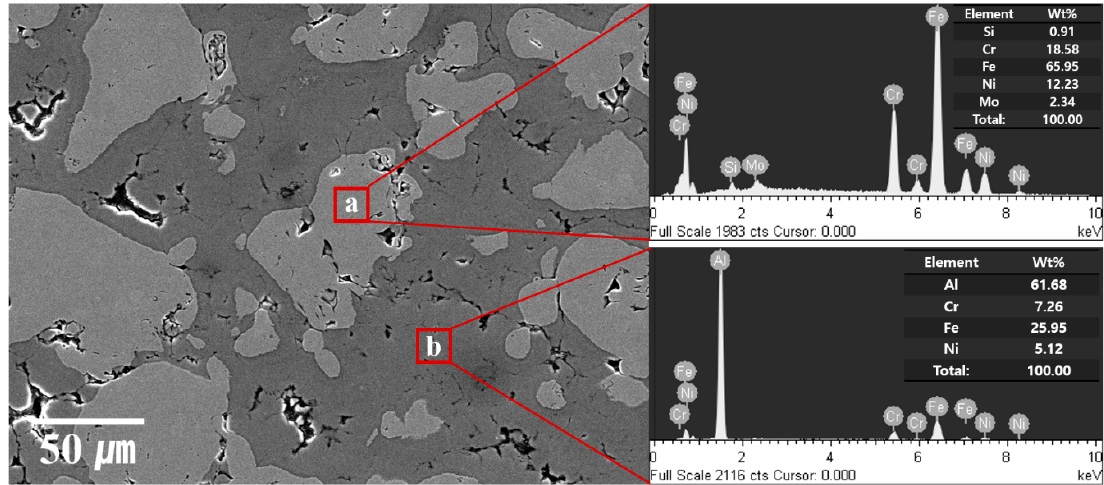
Figure 6. EDS analysis of areas ( a ) and ( b ) of the Al-50 vol.% SUS316L composite.